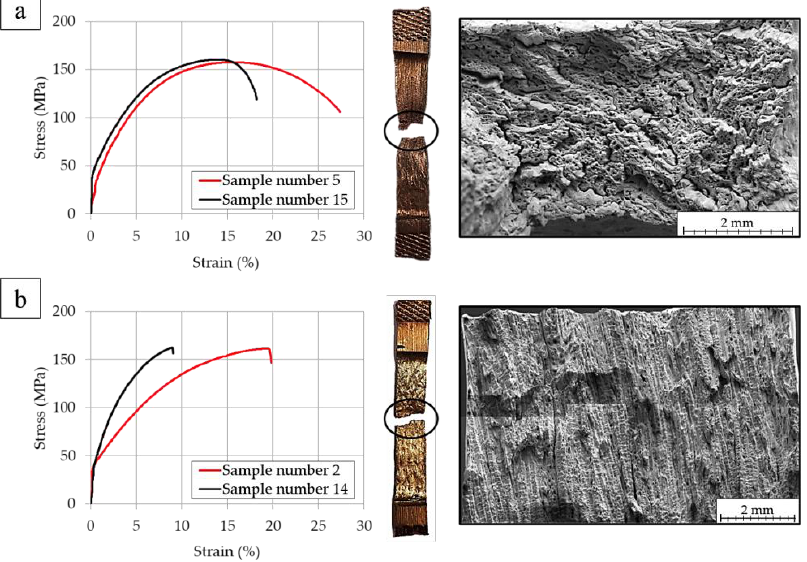
Figure 7. Stress-stress curves along with the images of the tested samples after uniaxial tensile test and a panoramic image of the fracture, where ( a ) samples number 5, 15 ( b ) samples number 2, 14 (according to Figure 6).